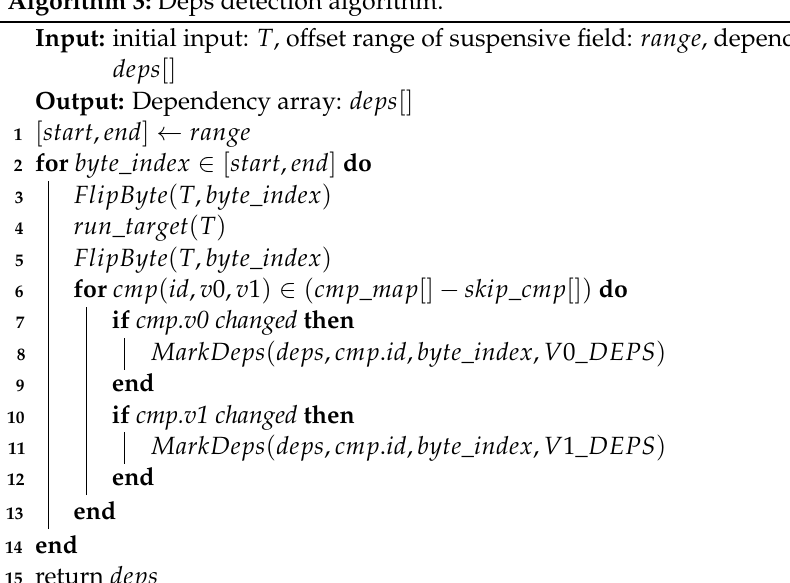
Algorithm 3: Deps detection